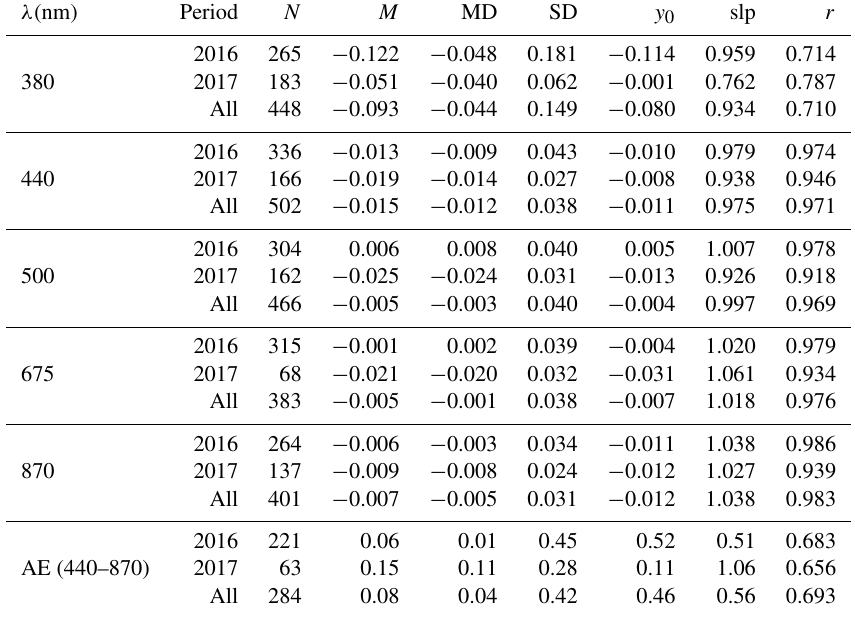
Figure 2. Aerosol optical depth (AOD) values from the Sun, Moon, and star photometer at Granada (Spain) from the first to third Moon quarters in July 2016. Panel (f) shows the Ångström exponent (AE) calculated with the wavelengths of 440, 500, 675 and 870nm (436, 500, 670, and 880nm for the star photometer). Moon phase angle (MPA) is represented with a black line in each panel. Table 2. Statistical estimators of the differences between the aerosol optical depth (AOD) from the Moon and star photometers for different wavelengths and periods. N is the number of data used; M , MD, and SD represents the mean, median, and standard deviation of these differences, respectively; y 0 , slp, and r are the y intercept, slope, and correlation coefficient from the linear fit between the AOD from the Moon and star photometers. These estimators are also presented for the Ångström exponent (AE) in the 440–870nm range. λ( nm